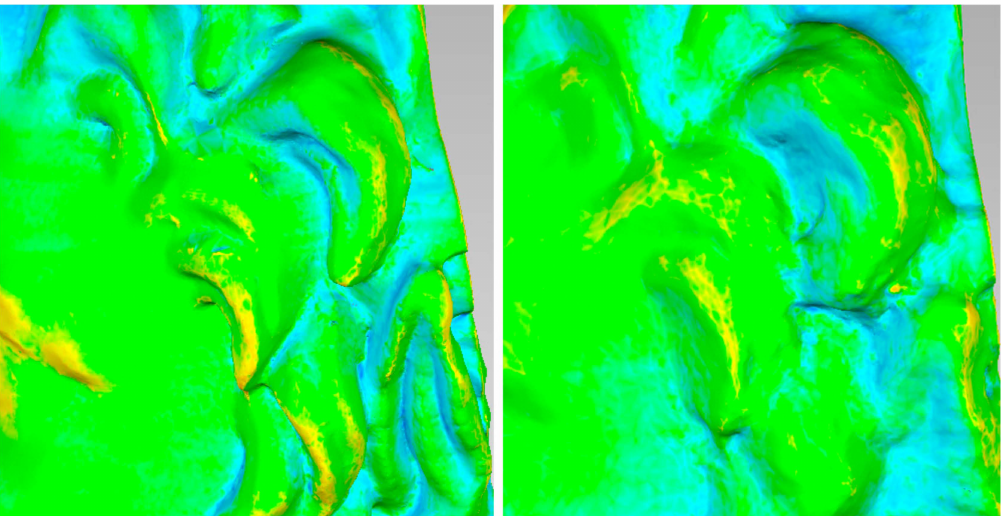
Figure 15. Details of the Satyr’s curls. ( left ) laser-scanning; ( right ) second photogrammetry (scale bar is the same of Figure 14).